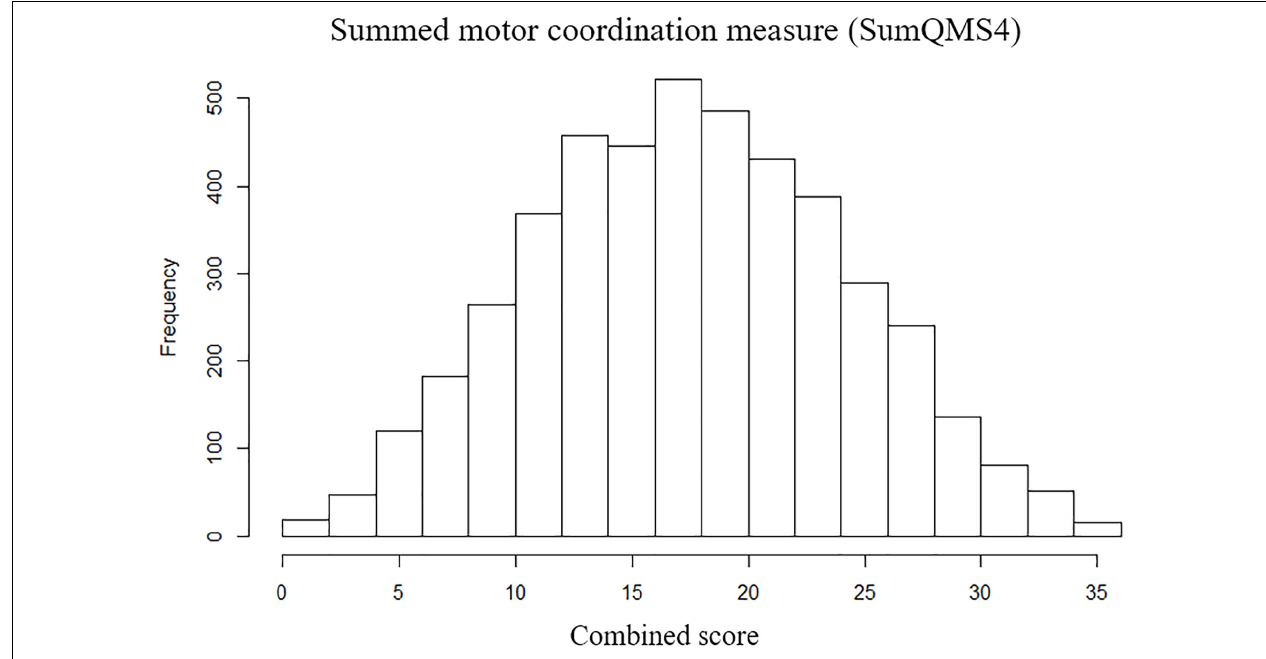
FIGURE 2 | Distribution of summed motor coordination measures (SumQMS4) derived from the MABC test components to reflect an overall motor coordination score, and a maximum possible score of